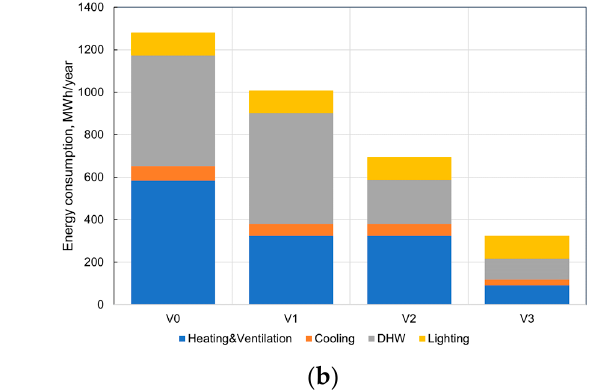
Table 12. Energy performance indicators—variant 3.